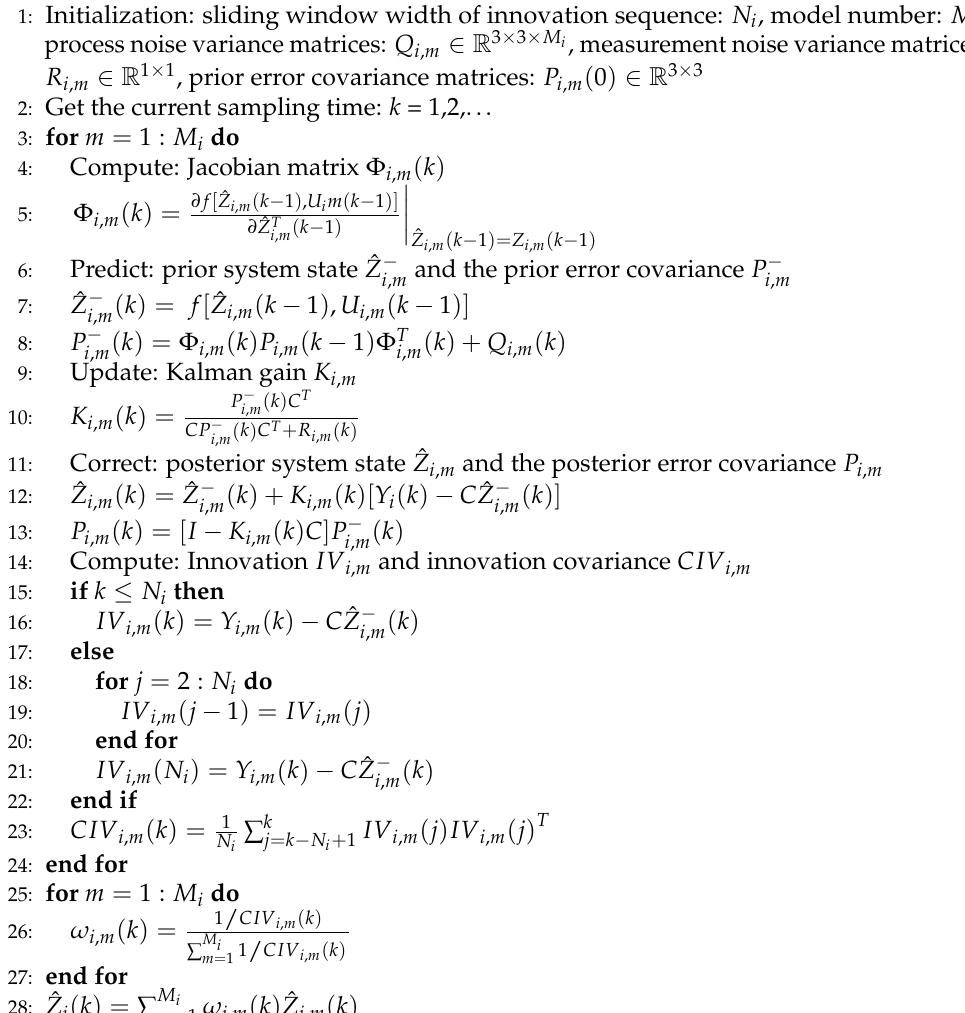
Algorithm 1 Multiple-model augmented-state Extended Kalman Observer